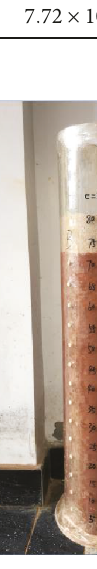
Figure 3: Unsaturated permeability test.